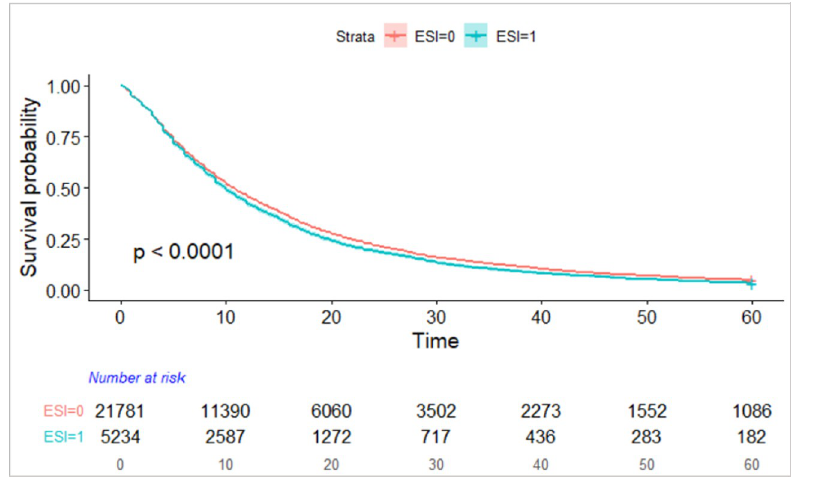
Fig 3. KM survival curve of time to first publication for ESI (1) vs. not-ESI (0) investigators.